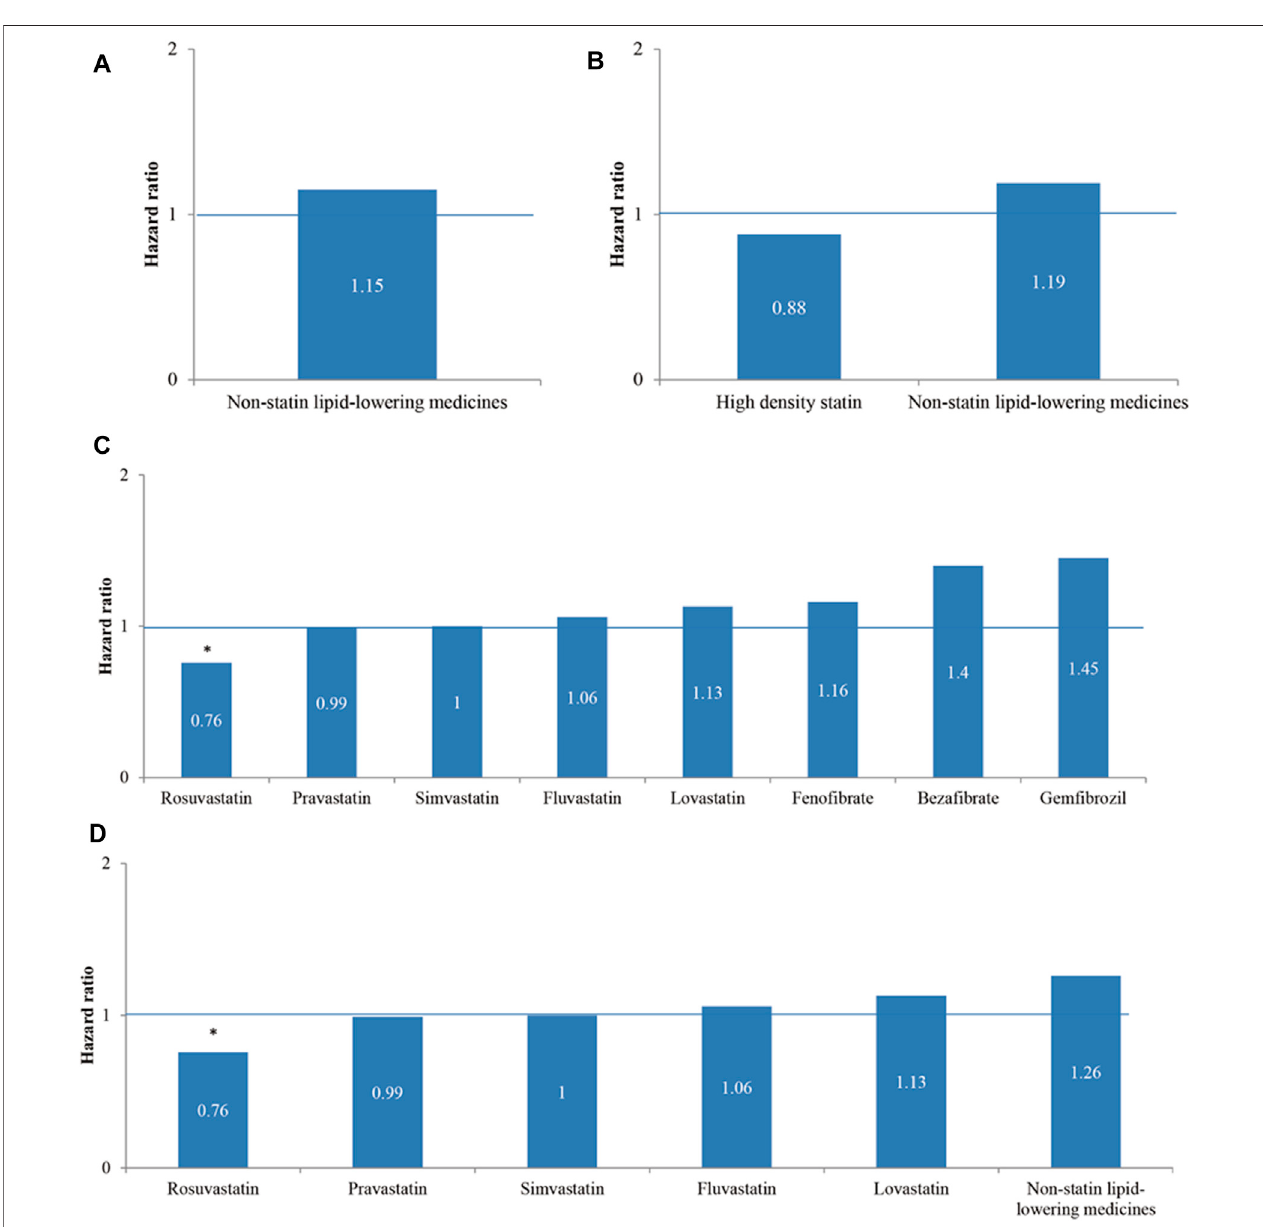
FIGURE 2 | The hazard ratios of rehospitalization due to ischemic stroke (reHospIS) for hyperlipidemic patients grouped by categories of lipid-lowering medicines they took regularly using univariable Cox proportional hazards regression. (A) Nonstatin lipid-lowering medicines versus statins (reference group, ref); (B) high-density statins (Atorvastatin, Rosuvastatin, and Simvastatin) and nonstatin lipid-lowering medicines versus low-density statins (Beza fi brate, Gem fi brozil, and Feno fi brate) (ref); (C) Rosuvastatin, Simvastatin, Lovastatin, Pravastatin, Fluvastatin, Beza fi brate, Gem fi brozil, and Feno fi brate versus Atorvastatin (ref); (D) fi ve individual statins of Rosuvastatin,Simvastatin,Lovastatin,Pravastatin,andFluvastatinversusnonstatinlipid-loweringmedicines(ref).Theasteriskrepresentsastatisticallysigni fi canthazard ratio ( p < 0.05).